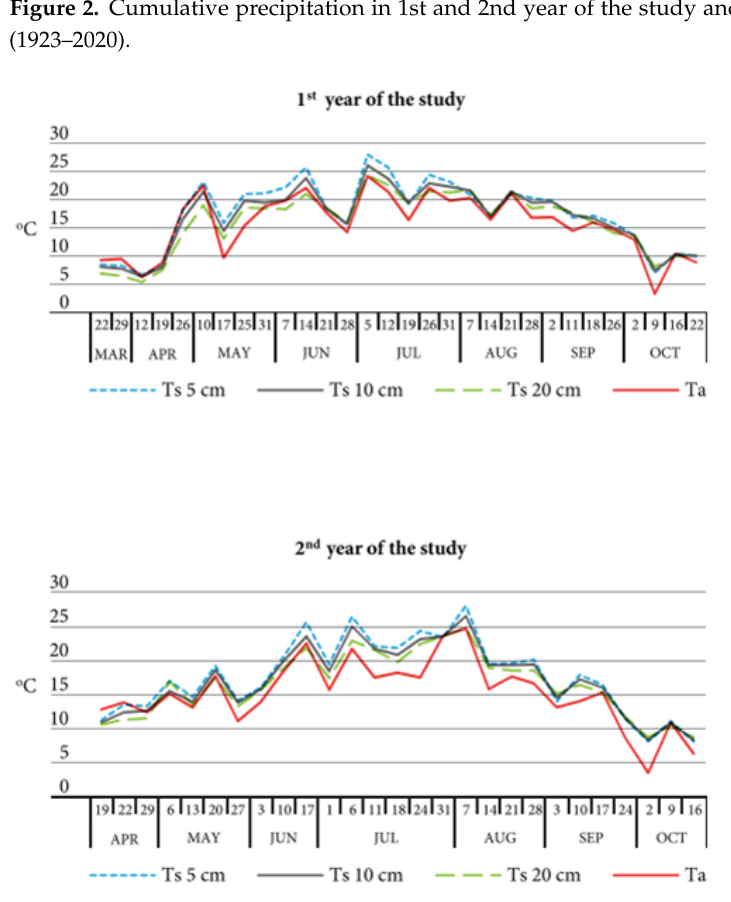
Figure 3. The air ( Ta ) and soil temperature ( Ts ) at a depth of 5, 10, and 20 cm on the test dates.